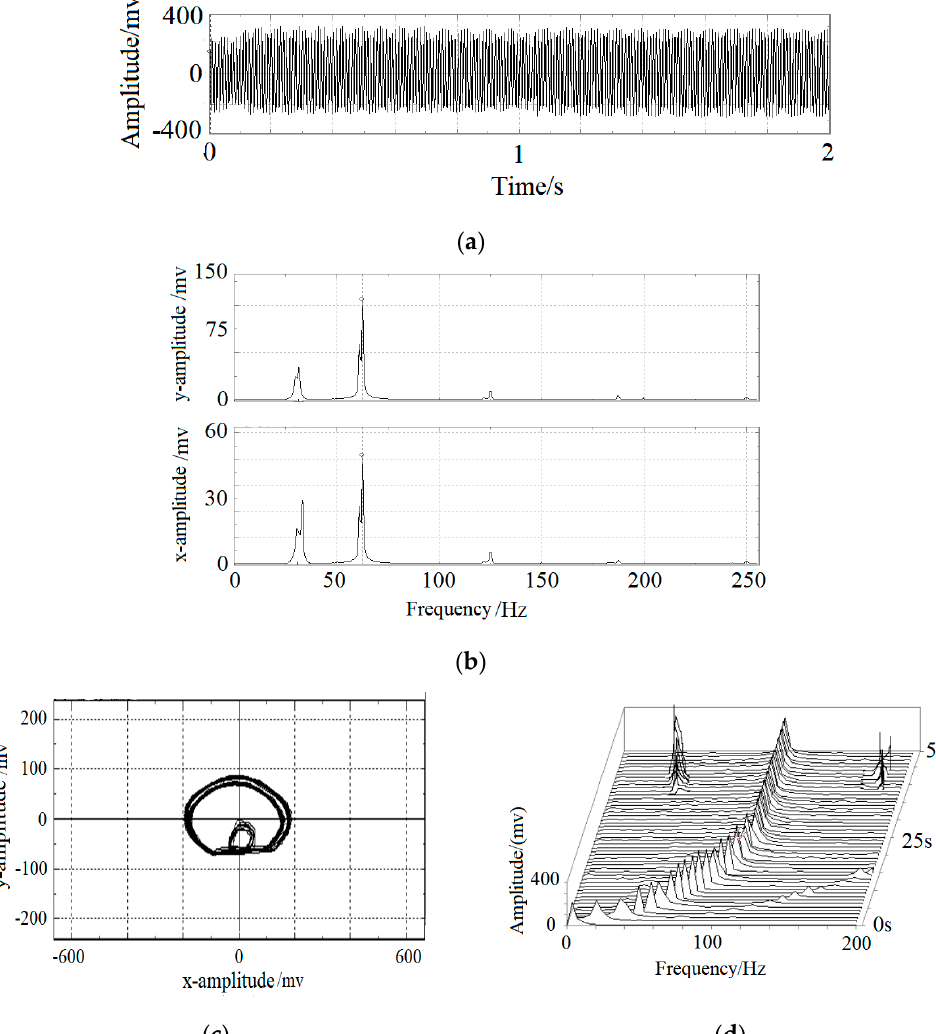
Figure 13. Dynamic response of the floating ring system (test result), when λ = 0.035 and speed ratio is S = 1: ( a ) time-domain waveform; ( b ) the FFT spectrum of rotor; ( c ) axis trajectory; ( d ) waterfall diagram .